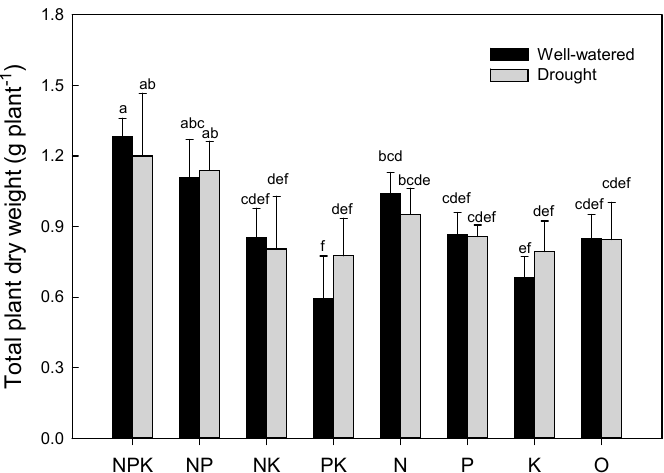
Figure 2. Interactive effects of drought and the N, P and K nutrients applied individually or in combination, or with no nutrient application (0) on the total dry weight (shoots + roots) of the maize seedlings at day 20 after sowing. The error bars represent the standard errors of the mean ( n = 3) and fit within the plot symbol if not visible. Means accompanied by different letters are significantly different at p < 0.05.